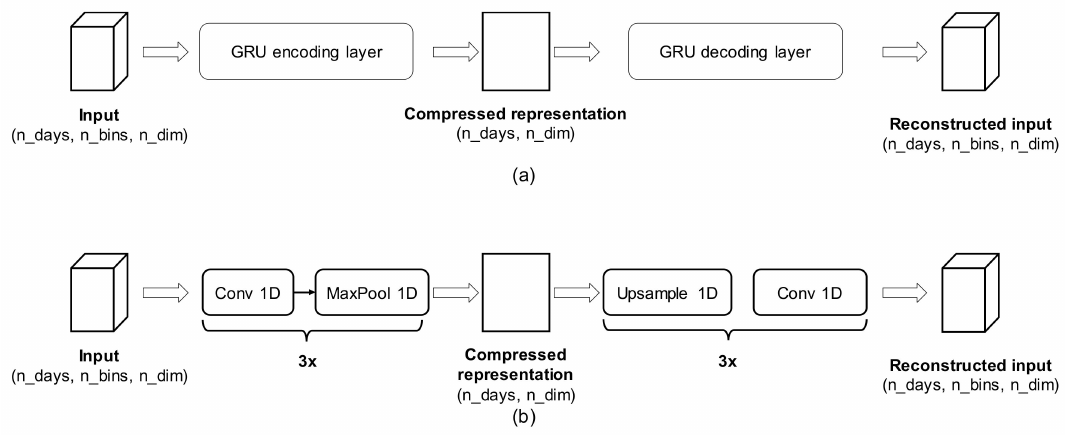
Figure 5. AutoEncoder (AE) architectures for learning the compressed representation of daily multi-sensor profiles. ( a ) GRU (gated recurrent unit) based AE; and ( b ) one-dimensional convolutional (CONV1D)